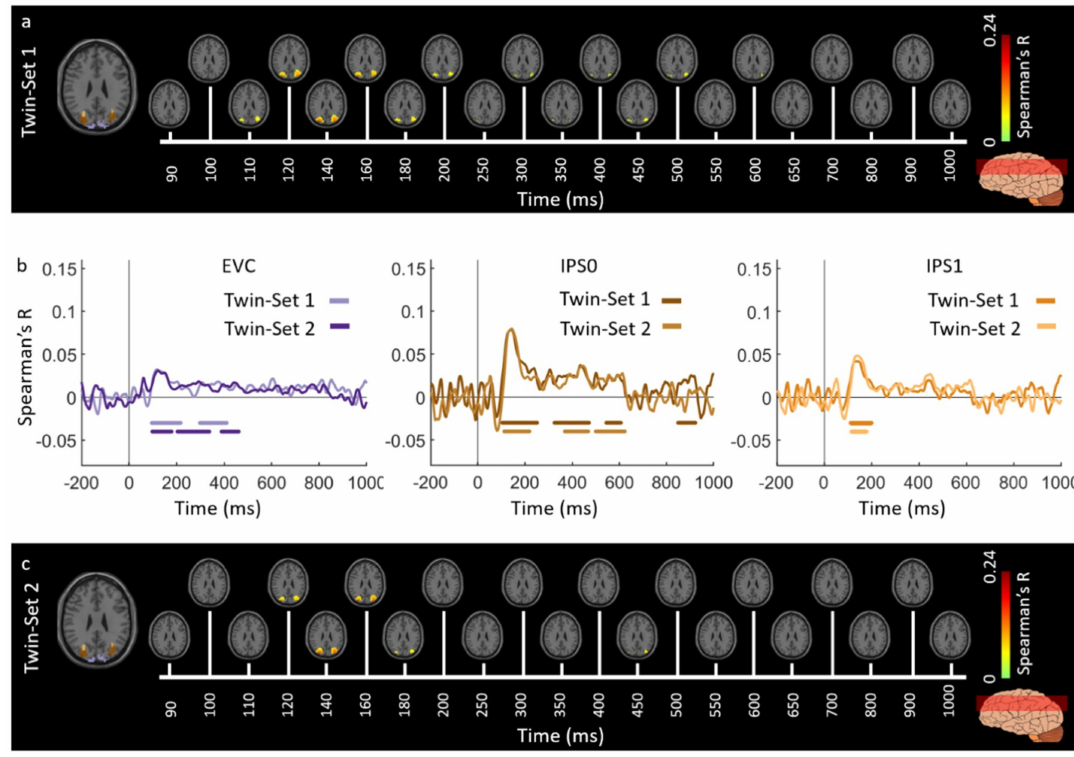
Figure 3. Experiment 1 Twins-set spatiotemporal neural dynamics of vision in dorsal stream: ( a ) An axial slice encompassing early visual cortex (EVC) and dorsal ROIs, inferior parietal sulcus (IPS0 and IPS1). The significant correlation maps for Twin-set 1 in this axial slice depicted over time (n = 15, cluster-definition threshold P < 0.001, cluster threshold P < 0.01); ( b ) The correlation time series are computed based on spatially restricted searchlight voxel-wise fusion analysis (see Methods). The depicted curves from left to right compare these time series in EVC and dorsal ROIs, IPS0 and IPS1 for Twin-set1 and Twin-set2. Significant time points depicted with color coded lines below the graphs are determined with sign-permutation tests (n = 15; P < 0.01 cluster-definition threshold, P < 0.01 cluster threshold); ( c ) The significant correlation maps for Twin-set 2 in the same axial slice as (a) depicted over time (n = 15, cluster-definition threshold P < 0.001, cluster threshold P <